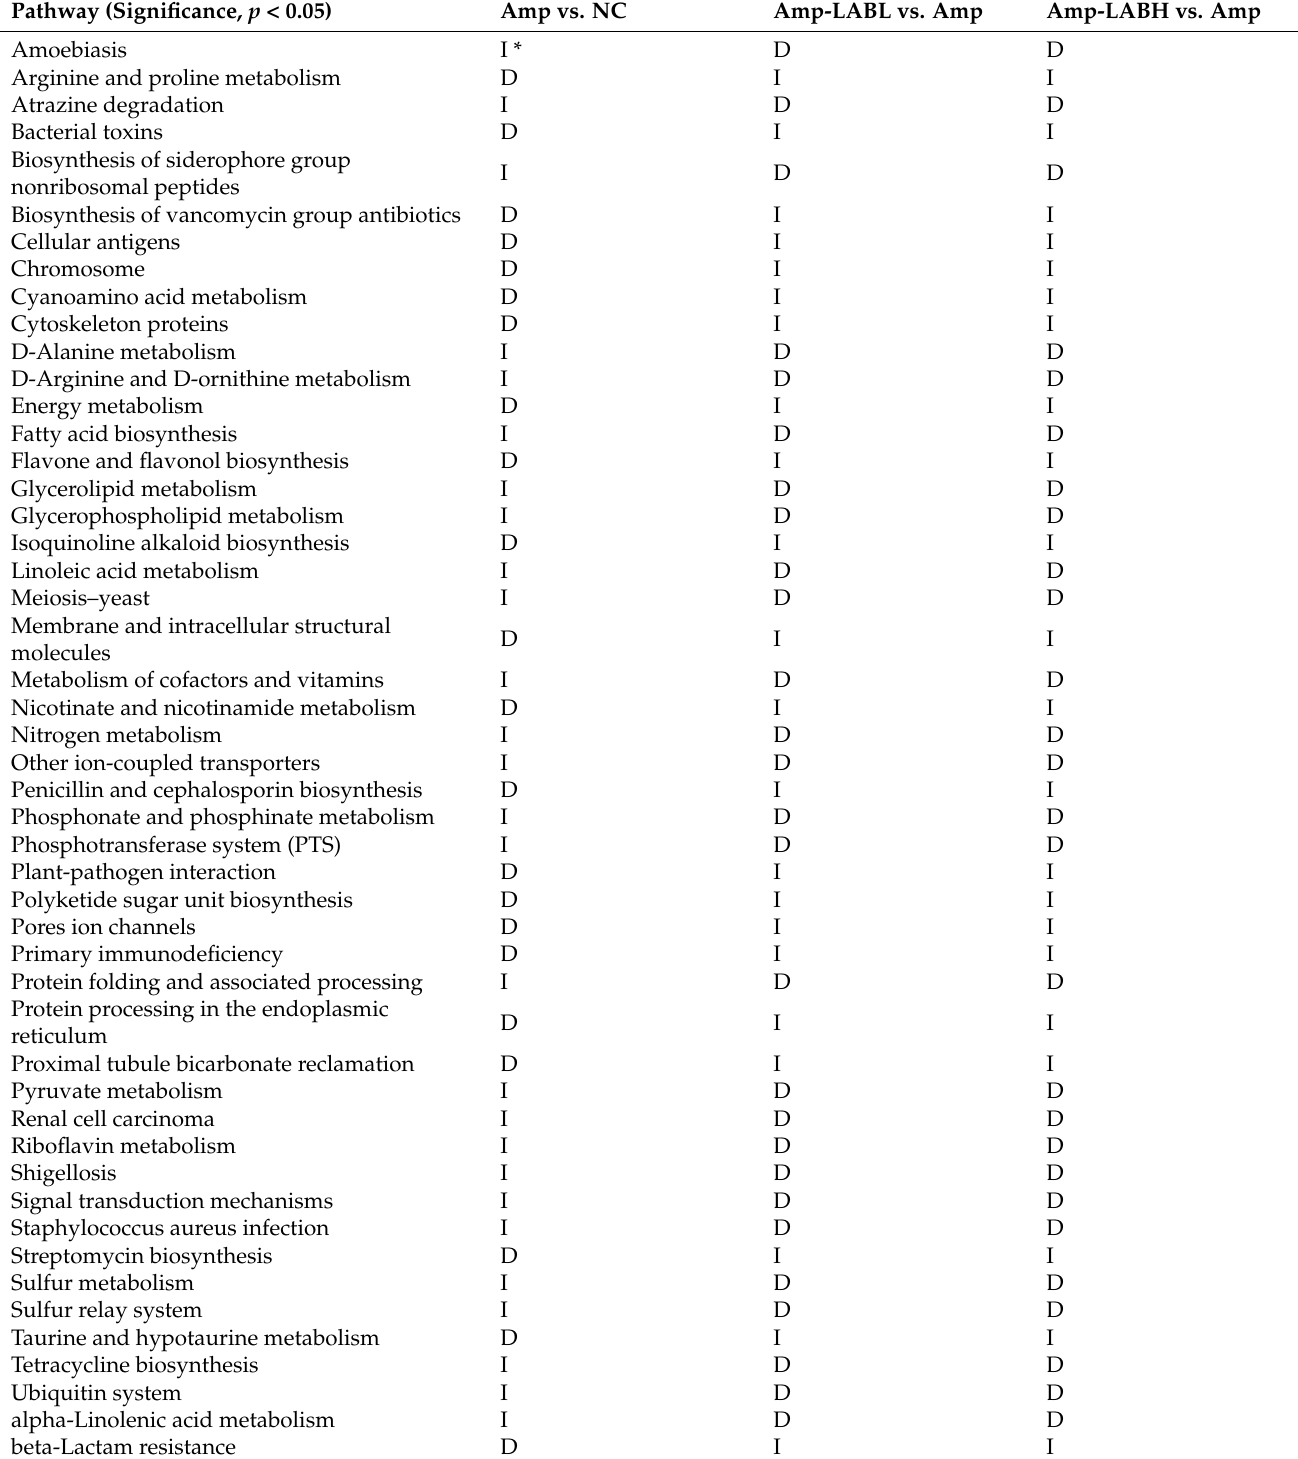
Table 3. Egg NOG functional annotations of